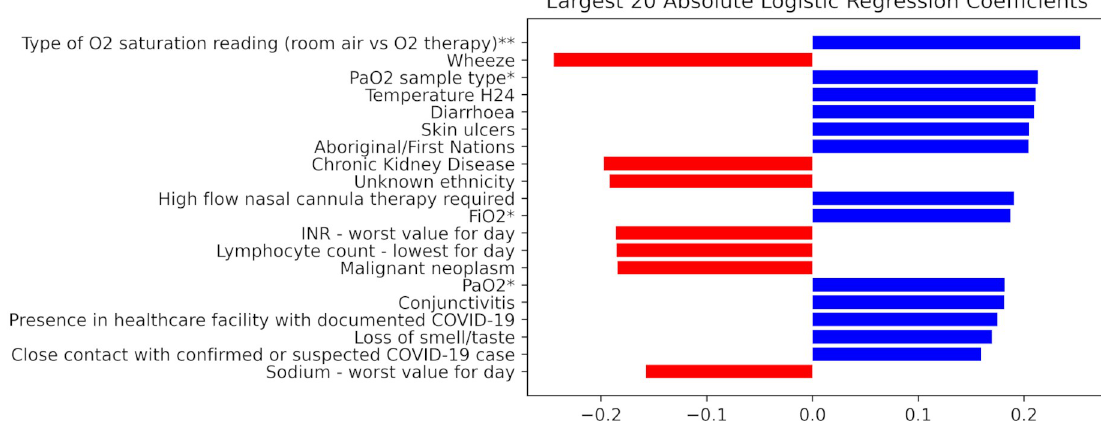
Fig 3. Largest twenty coefficients by absolute value as defined by logistic regression. These represent the model’s weighting of the variable of interest on the outcome (whether or not invasive ventilation will be required by day 2 or 3 of ICU admission). Positive values signify that as variable increases, the risk of requiring invasive ventilation increases. Negative values signify that as the variable decreases, the risk of requiring invasive ventilation decreases. H24—Highest in first 24 hours of hospital admission. ‘Day’ refers to the first 24 hours of ICU admission unless otherwise specified. ’Worst’ refers to the worst value as relating to the APACHE II score. �� Closest to pre-intubation on day one. � From ABG with worse P:F (PaO2 divided by FiO2) ratio for the